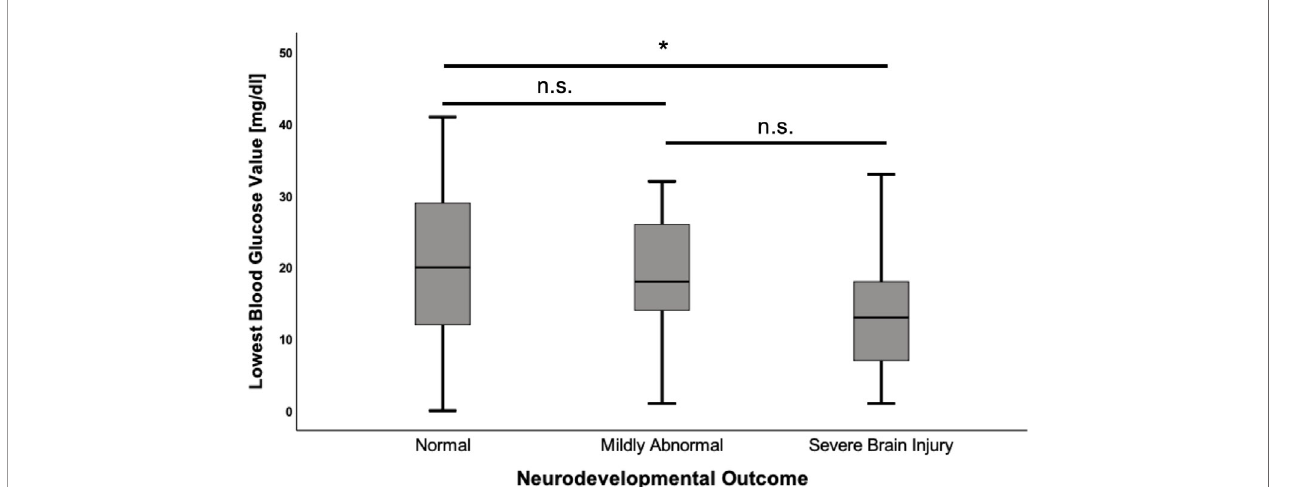
FIGURE 2 | Lowest blood glucose values according to neurodevelopmental outcome. Values are displayed as mean ± standard deviation. ANOVA with Tukey post hoc comparison showed signi fi cant differences in the mean for normal neurodevelopmental outcome (n = 53) vs. severe brain injury (n = 14) (20.6 ± 11.0 vs. 12.3 ± 8.6, p = 0.022). Comparison between the remaining groups showed no signi fi cant differences. *p < 0.05, n.s, not signi fi